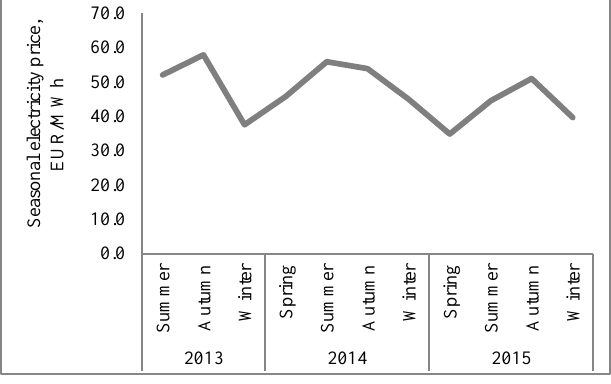
Fig. 3. Seasonal electricity price profile (Nord Pool Spot,